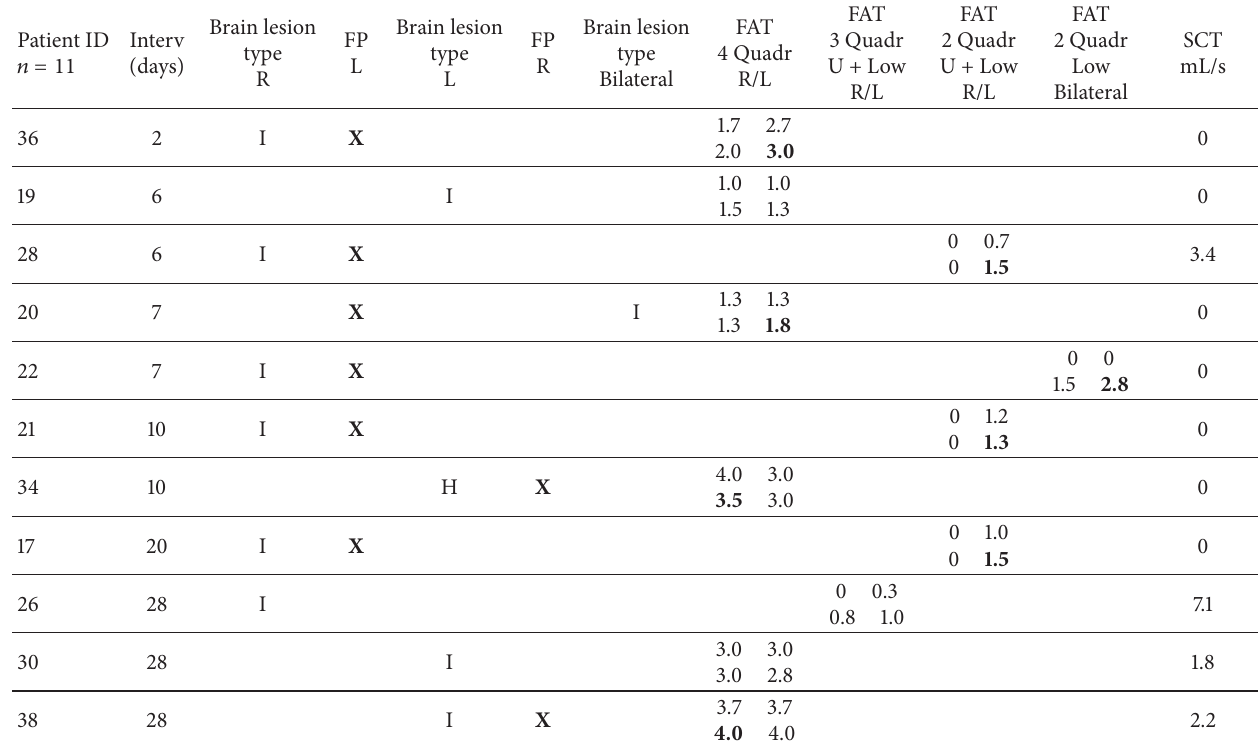
Table 1: Four-quadrant (upper, lower, right, and left) facial function in Group A (status days after stroke). Individual data are given for each patient with stroke and dysphagia ( 𝑛 = 11 ).